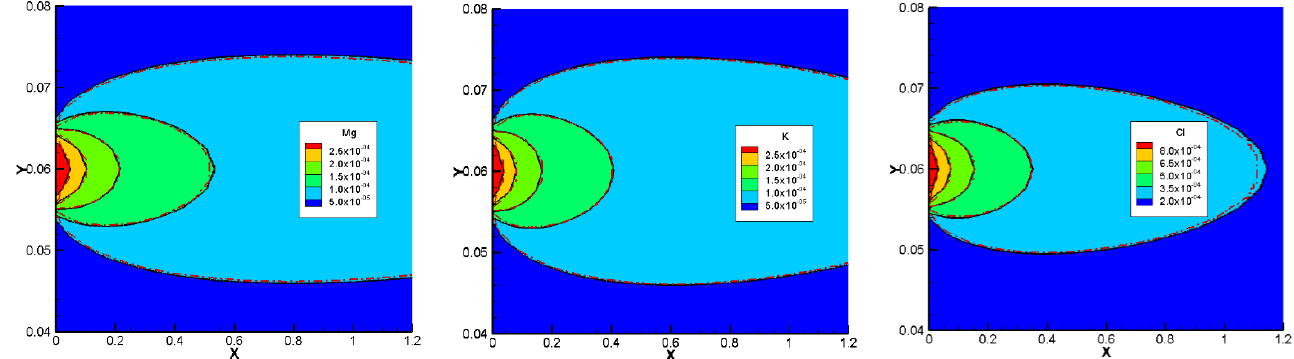
Figure 2. Comparison of the concentration results of the NPP (Colors), NC (solid black lines), and ‘Crunch’ (dashed red lines) models for 2D simulations of benchmark 3.